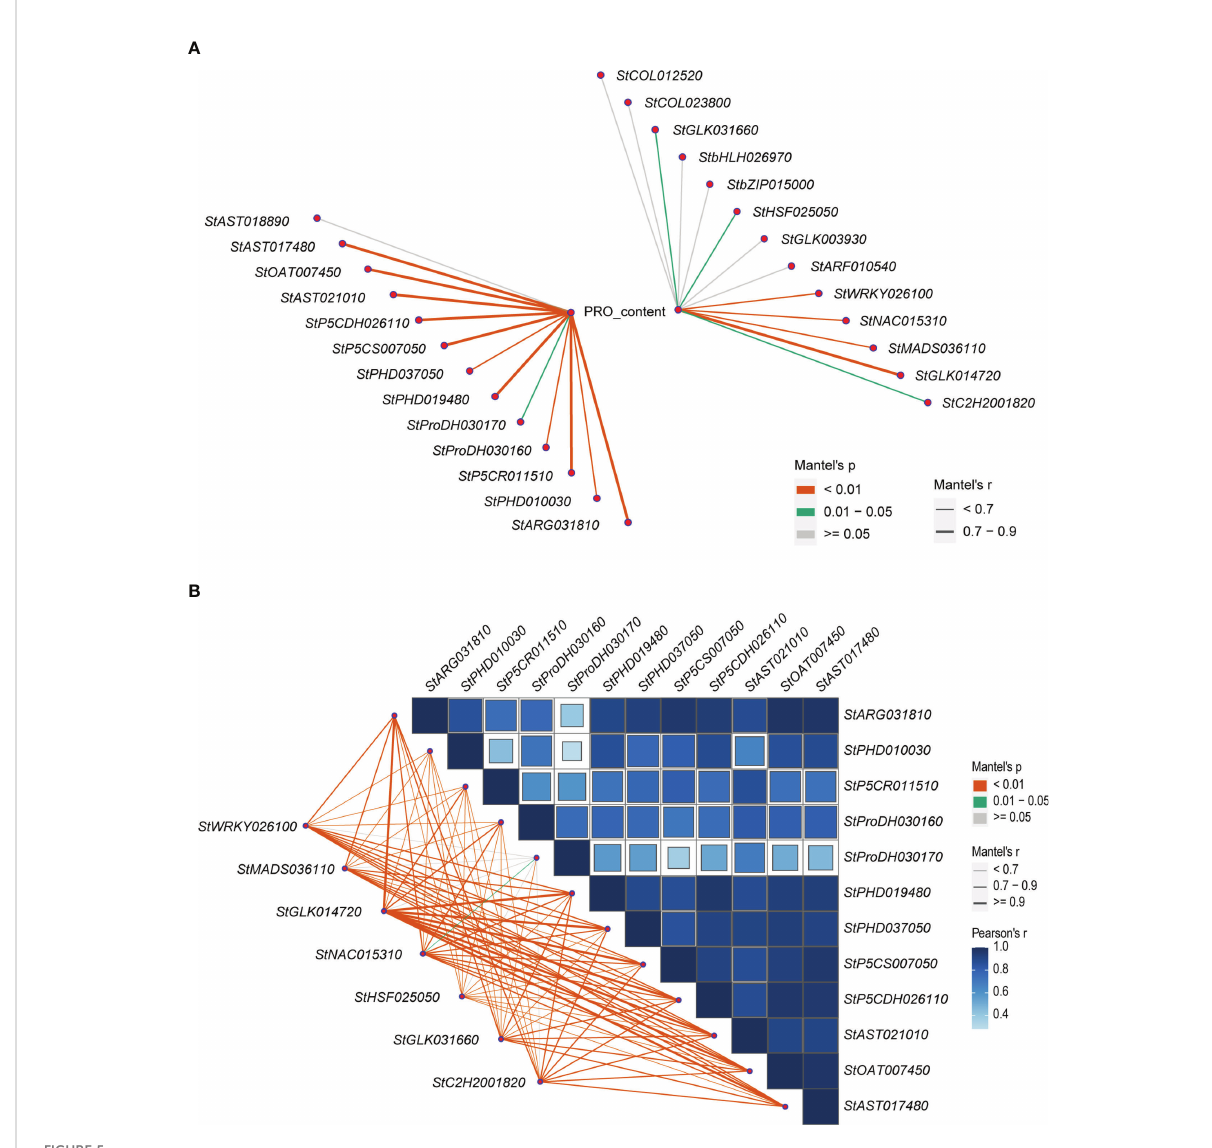
FIGURE 5 Correlation maps related to the proline contents, the expression levels of the structural DEGs and the TF-hub genes. (A) The correlations between the proline contents and the expression levels of the 13 structural DEGs in the proline metabolic pathway and the expression levels of the 13 TF-hub genes. (B) The correlations among the expression levels of the 12 structural DEGs in the proline metabolic pathway and between the expression levels of the 7 TF-hub genes and the 12 structural DEGs in the proline metabolic pathway. The lines correspond to the expression correlations between the 7 TF-hub genes and the 12 structural DEGs. The colors of the lines represent the Mantel ’ s p , and the thicknesses of the lines represent the percentage of the Mantel ’ s r. The intensity of the blue color and the size of the box indicate the degree of the expression correlation among the 12 structural